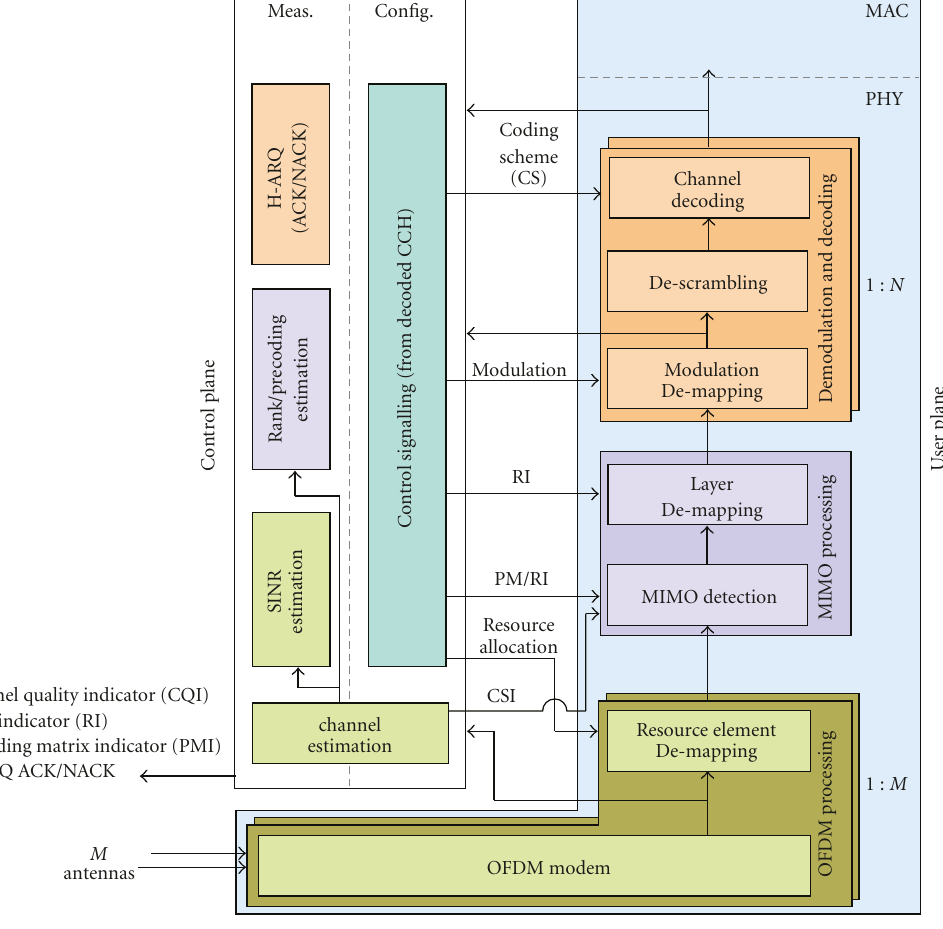
Figure 5: User Equipment Architecture